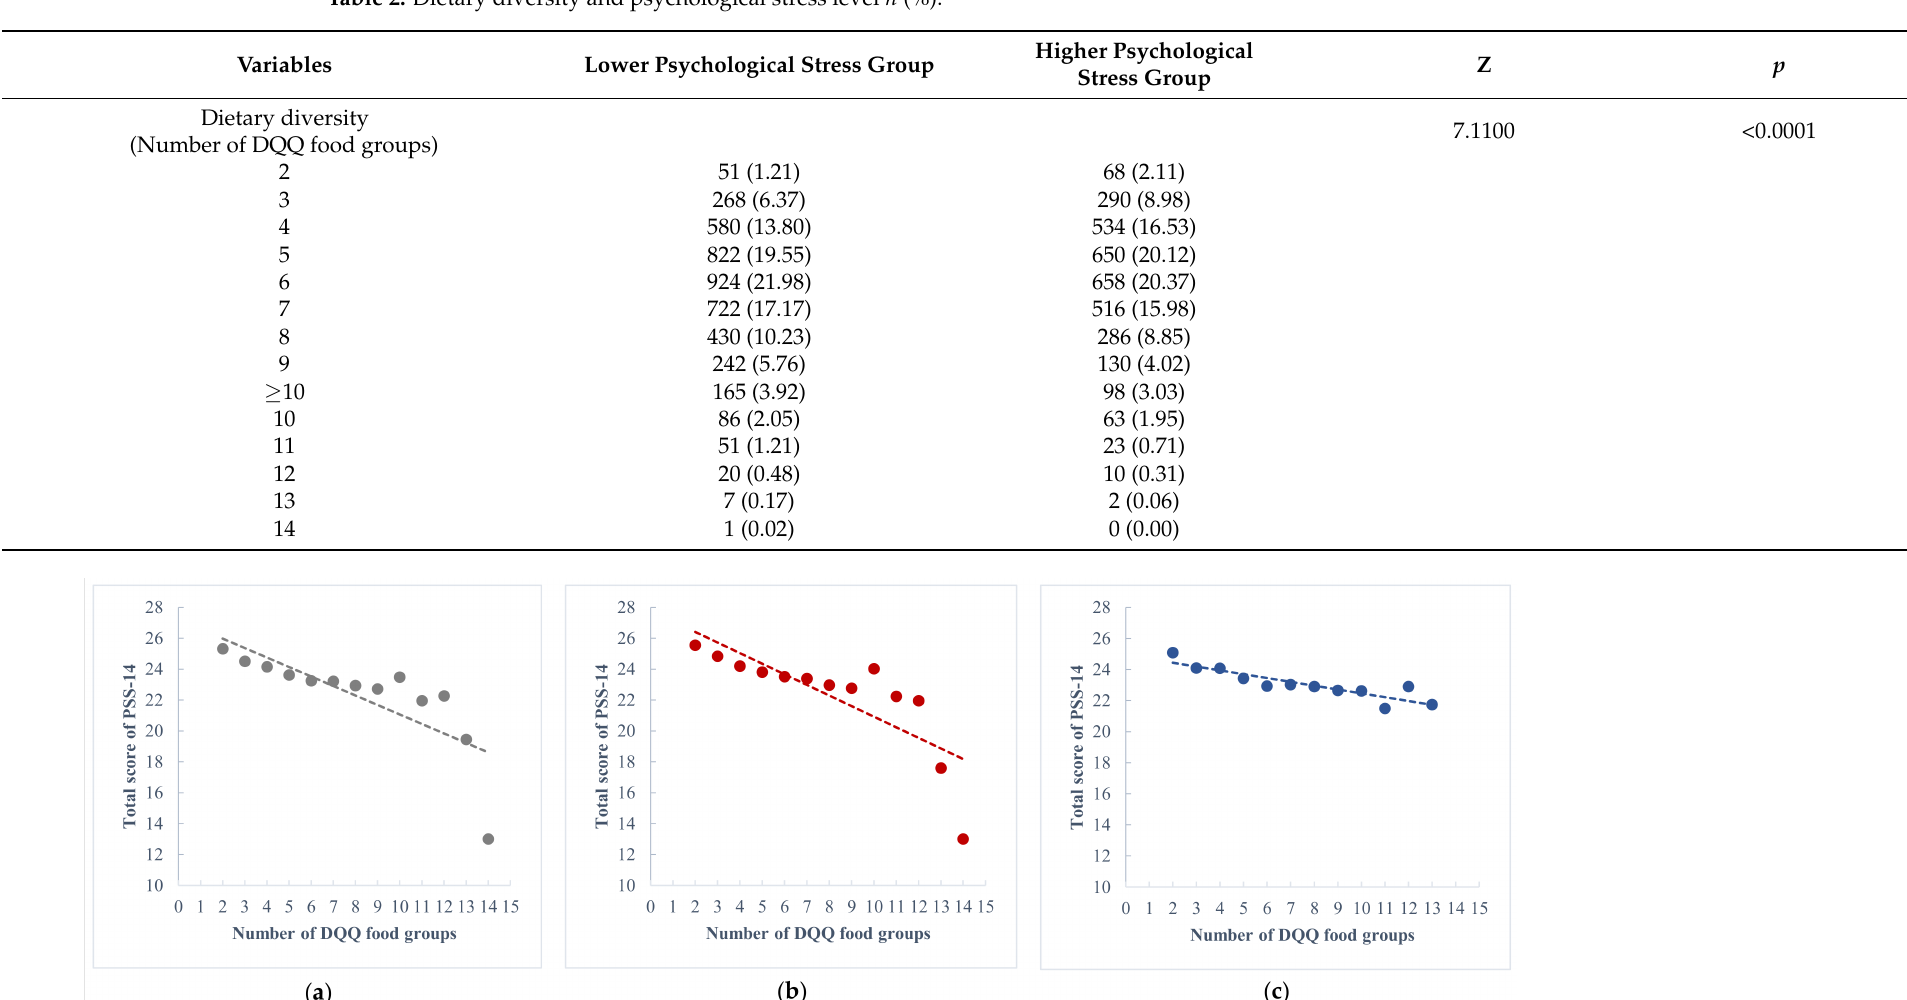
Table 2. Dietary diversity and psychological stress level n (%).